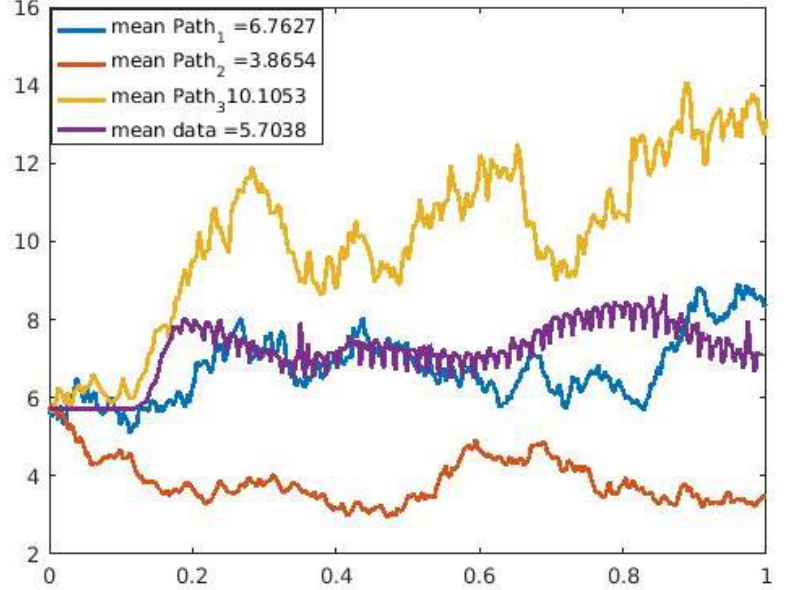
Figure 14. Graph showing three sample paths and time series plot for the U.S. COVID-19 deaths. For this time series, we see that sample path 1 closely predicts it and by comparison of the means, sample path 1 is closer in value to the mean of the time series